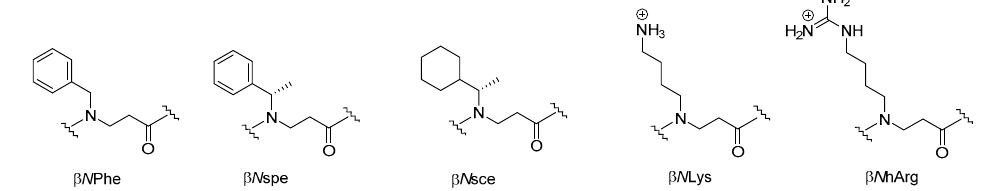
Figure 9. Structure of commonly used β -peptoid building blocks. β N Phe: N -(1-phenylethyl)- β -alanine; β N spe: N -( S )-(1-phenylethyl)- β -alanine; β N sce: N -( S )-(1-cyclohexylethyl)- β -alanine; β N Lys: N -(4-aminobutyl)- β -alanine; β N hArg: N -(3-guanidinobutyl)- β -alanine.